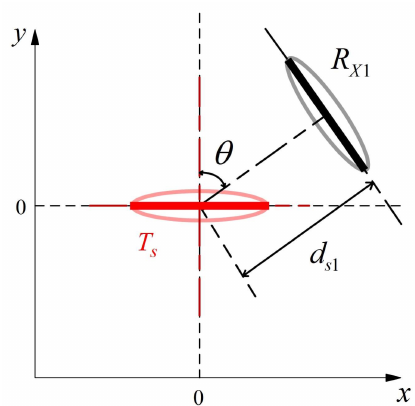
Figure 1. A simplified diagram of the single-receiver system.